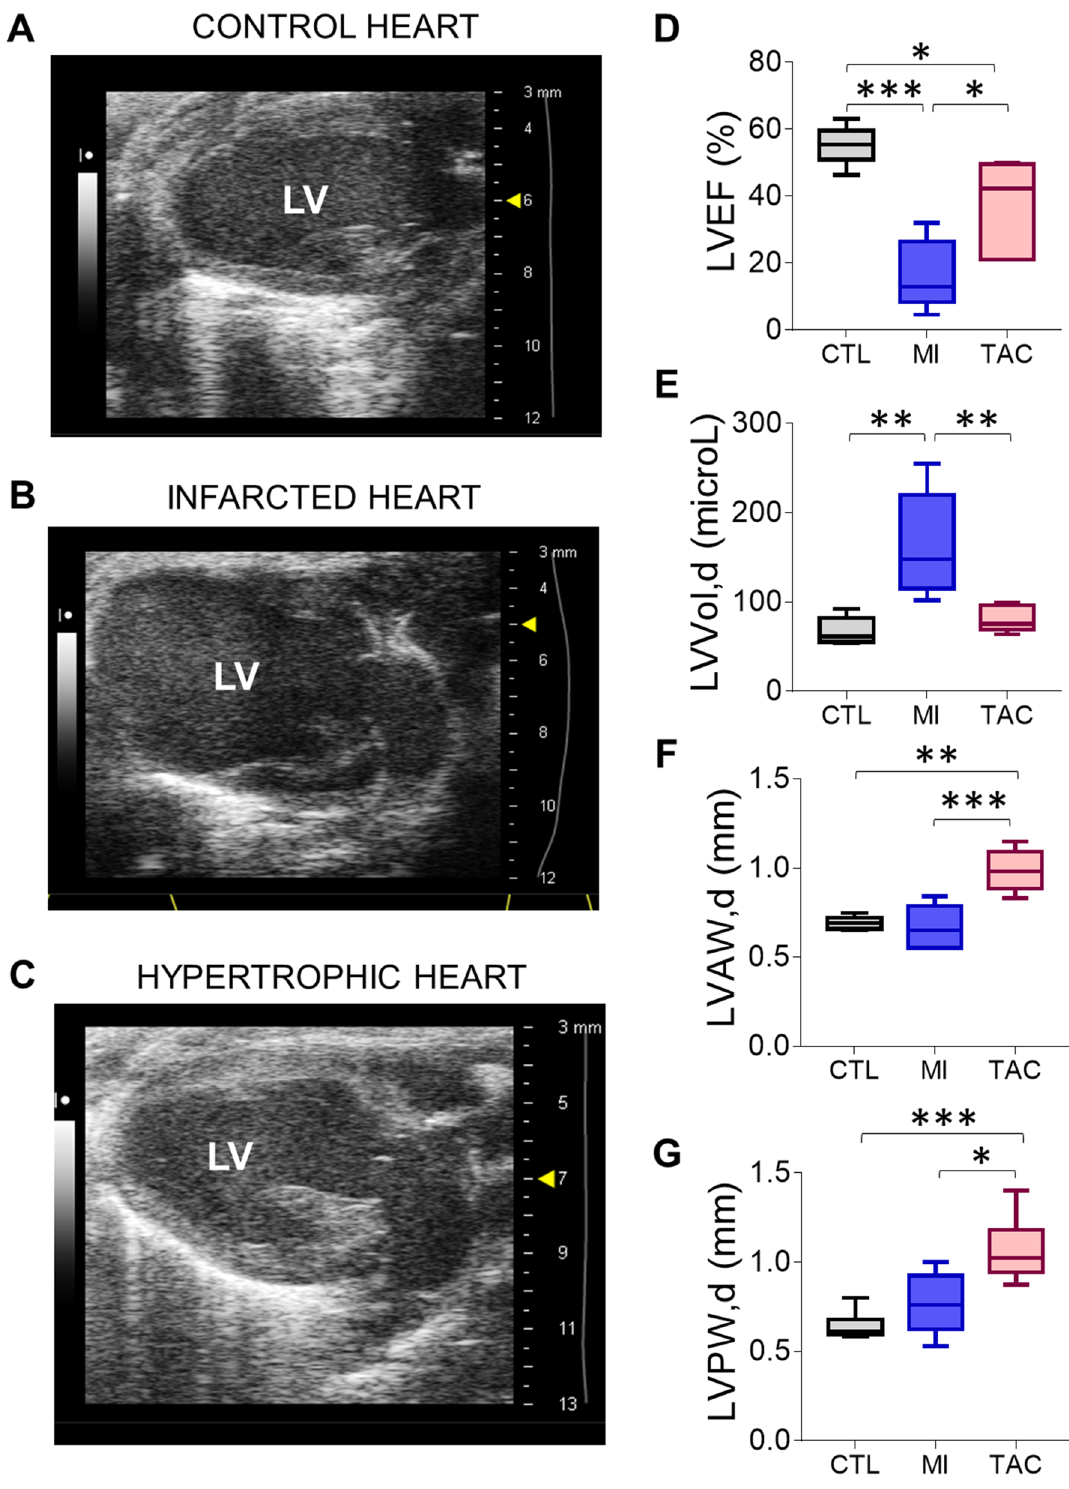
Figure 5. Assessment of cardiac function by echocardiography. ( A – C ) Representative echocardiography images of a control heart ( A ), an infarcted heart ( B ), and a hypertrophic heart ( C ). ( D – G ) Functional and structural parameters were quantified by echocardiography, including left ventricular ejection fraction (LVEF; D ), left ventricular end diastolic volume (LVVol,d; E ), left ventricular anterior wall thickness in diastole (LVAW,d; F ), and left ventricular posterior wall thickness in diastole (LVPW,d; G ). *p < 0.05, **p < 0.01, ***p < 0.001; one-way ANOVA followed by Bonferroni post-test. n = 6 per